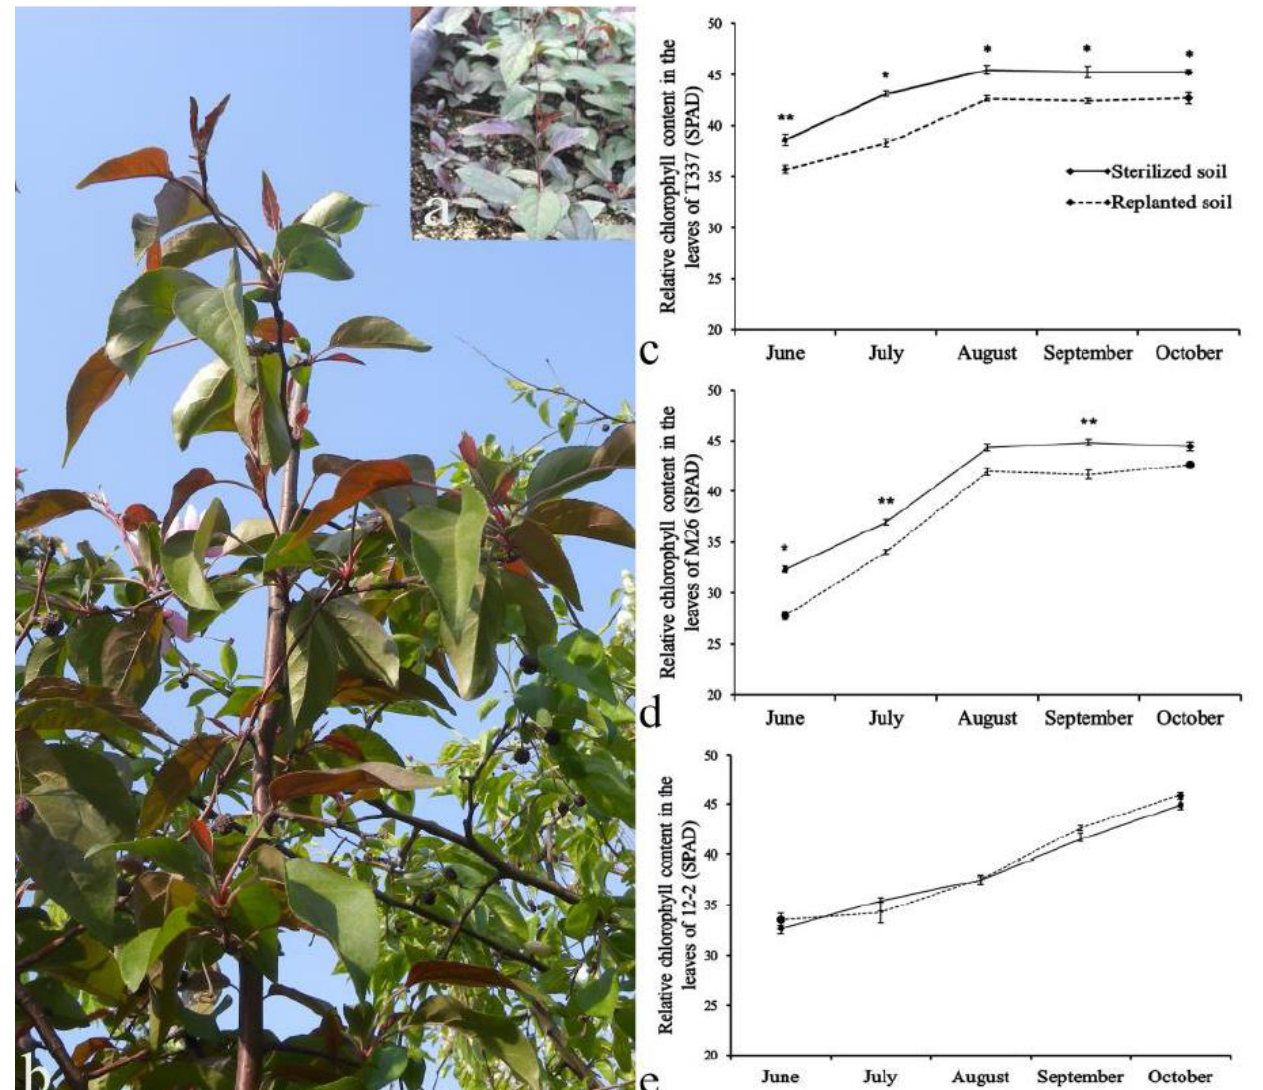
Figure 1. Growth of 12-2 and the relative chlorophyll content of the plants with different rootstock types planted in sterilized and replanted soil. ( a ): 30 d after transplanting the 12-2 plugs; ( b ): 3-year-old 12-2 plant; ( c – e ): relative chlorophyll content in the leaves of the three rootstocks. * p < 0.05; ** p < 0.01. Solid line represents the treatments in sterilized soil; dotted line represents the treatments in replanted soil. The same below.